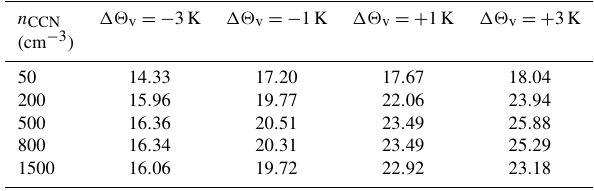
Table A4. Temperature sensitivity (in %K − 1 ) of rain evaporation for all n CCN values.